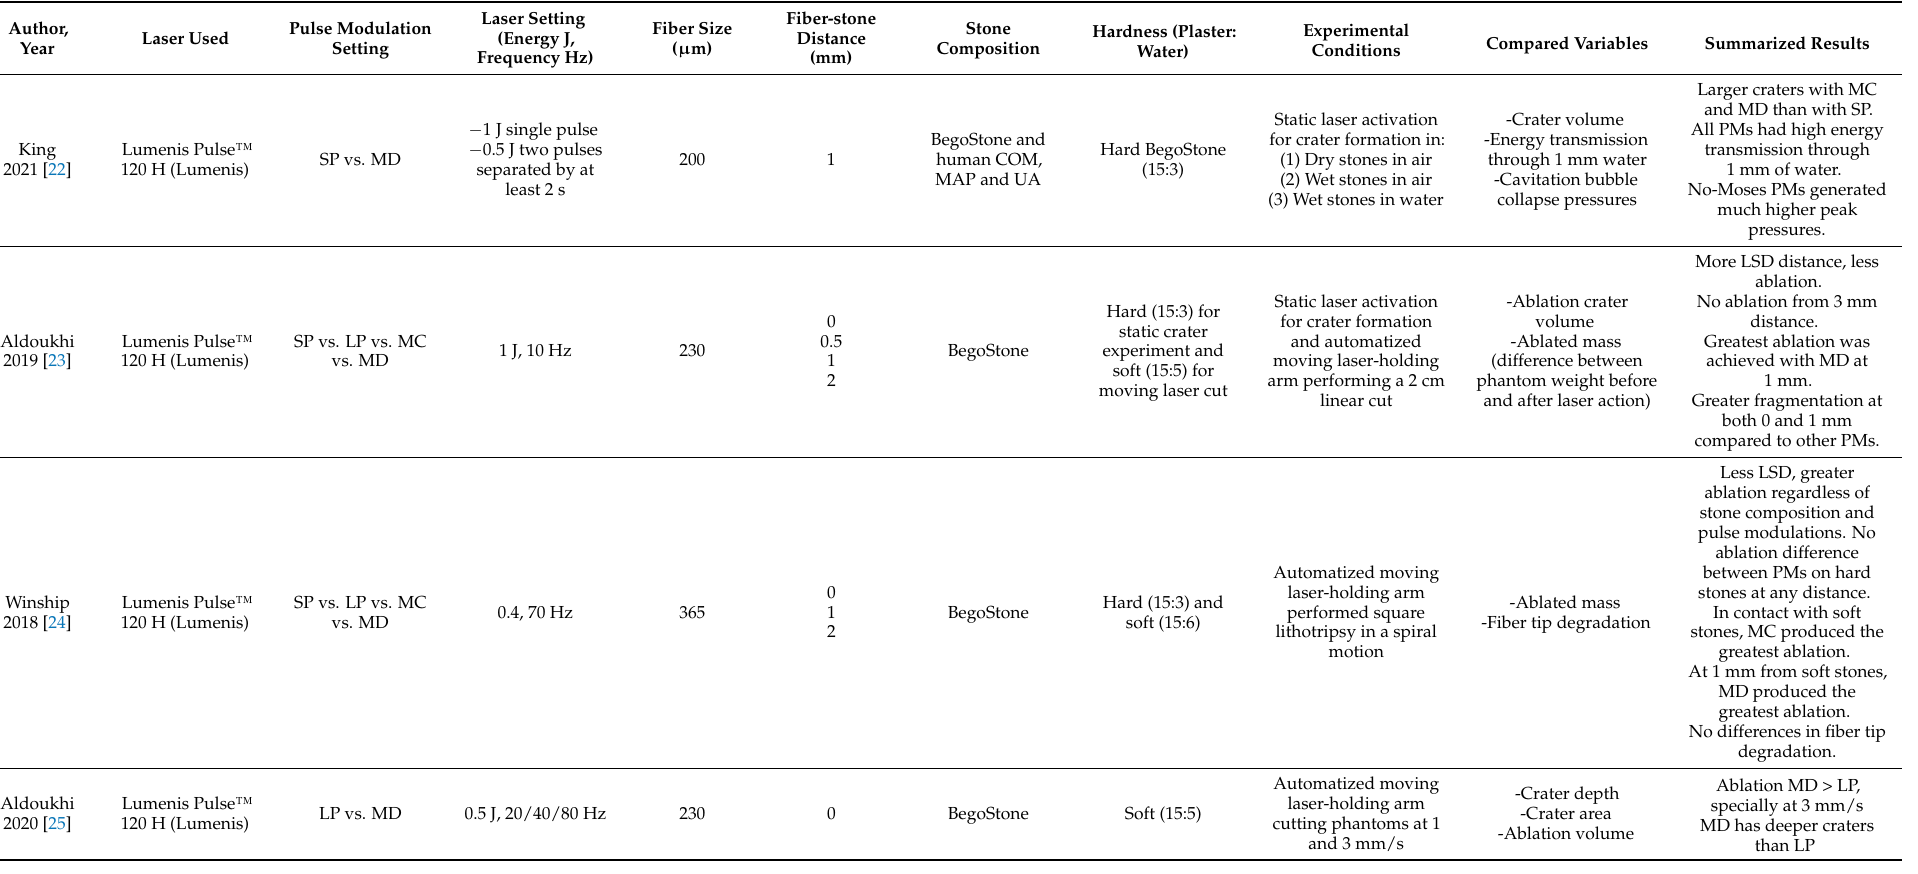
Table 1. Study details of the included in-vitro